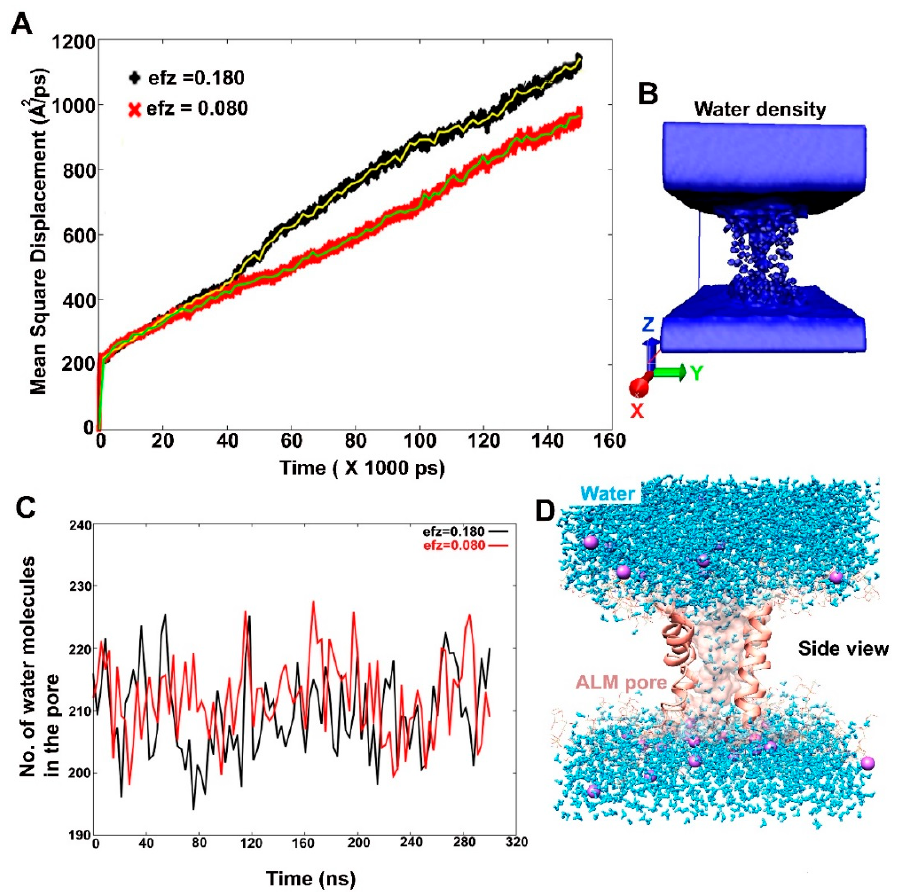
Figure 6. ( A ) The mean square displacement (Å 2 ps − 1 ) values of water calculated as a function of simulation time. Using the slope of MSD curve, the average di ff usion coe ffi cient was calculated to be 0.311 × 10 − 5 cm 2 s − 1 and 0.245 × 10 − 5 cm 2 s − 1 for Mem-sim1 and Mem-sim2, respectively. Mem-sim1 clearly shows higher displacement of water under the influence of a comparatively stronger external electric field (0.07 V nm − 1 ), ( B ) A diagrammatic representation of water density around the pore, ( C ) The number of water molecules present in the Alm F30 / 3 pore at a given time, ( D ) A cartoon representation of water molecules passing through the Alm F30 / 3pore. The front two monomers have been hidden for visual clarity.